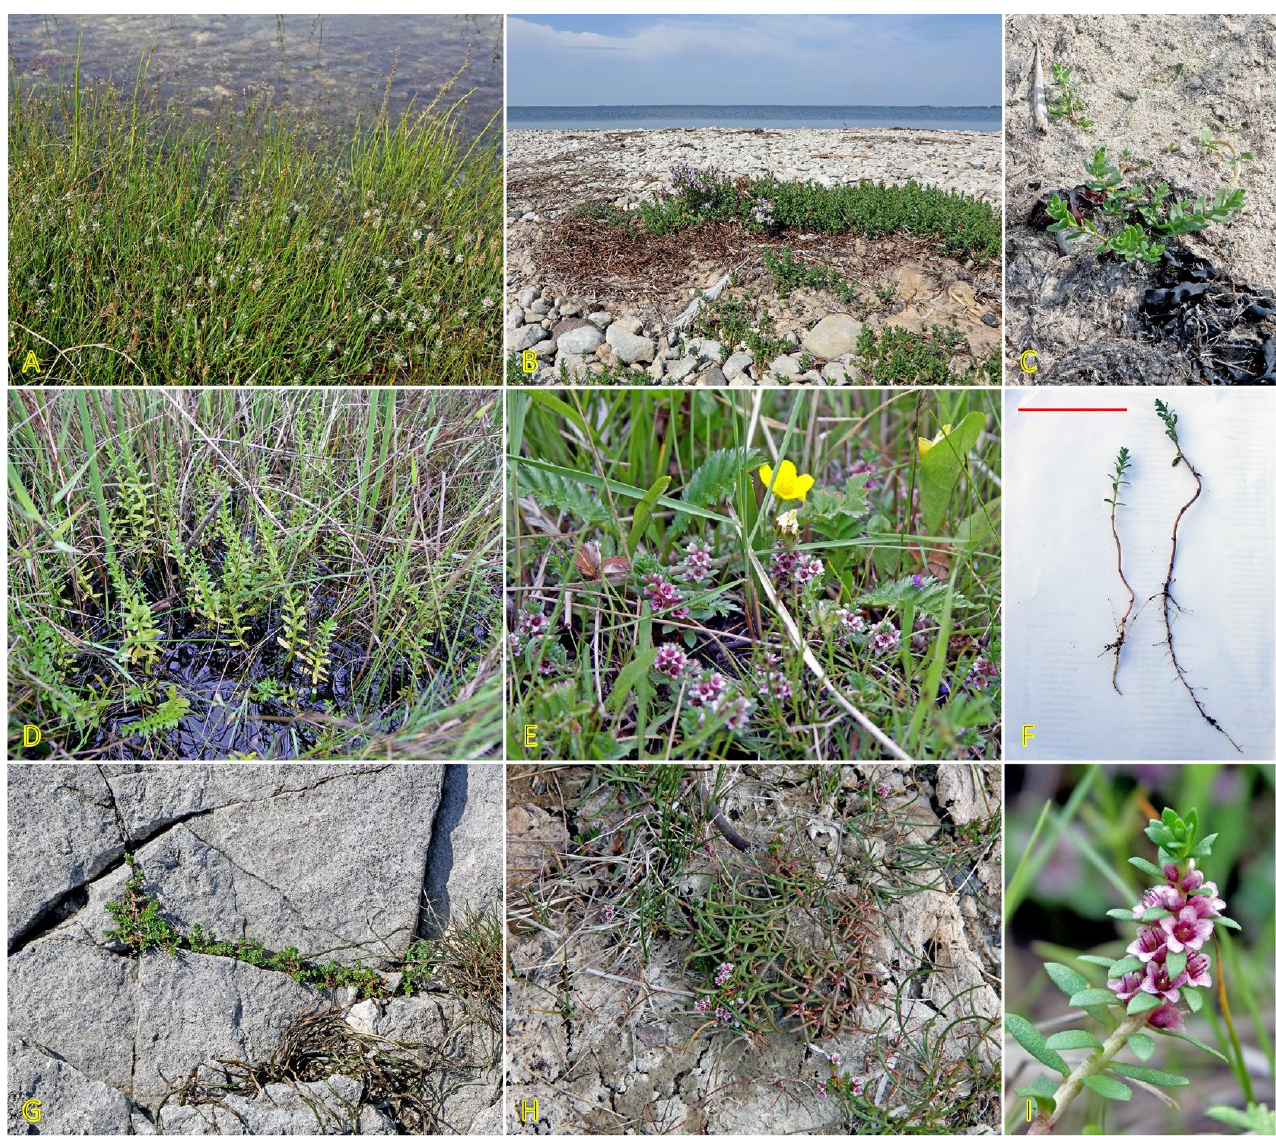
Figure 15. Lysimachia maritima plants together with Juncus sp. and Triglochin maritima on a wet coastal meadow on the island of Saaremaa, Estonia ( A ), on a shingle beach on the island of Hiiumaa, Estonia ( B ), on a wet sandy beach in Ainaži, Latvia ( C ), flooded coastal meadow in Liepāja, Latvia ( D ), flowering individuals together with Potentilla anserina on a wet coastal meadow in Mērsrags, Latvia ( E ), excavated individuals ( F ), on a rocky beach on the island of Kihnu, Estonia ( G ), on a gravel beach together with Spergularia marina on the island of Saaremaa, Estonia ( H ), flowering shoot ( I ).